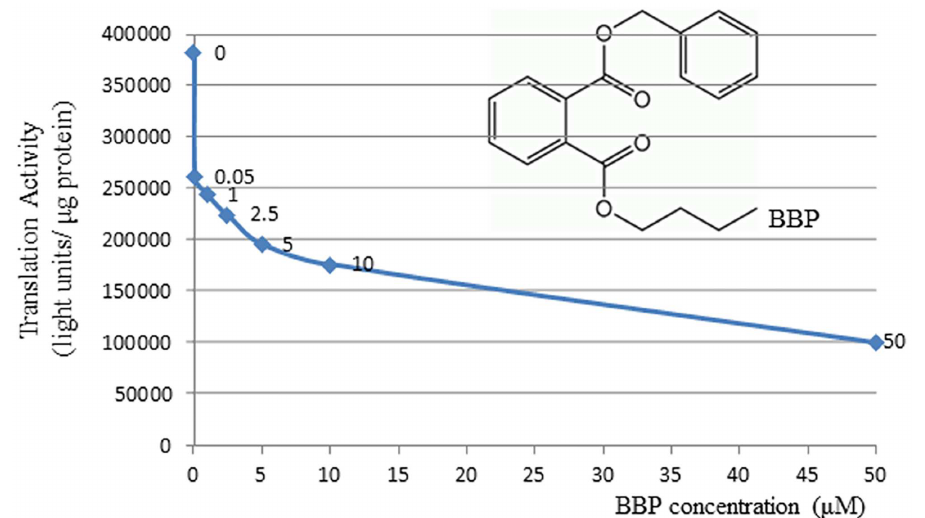
Fig 1. BBP inhibits mRNA translation in vitro . Rabbit reticulocyte lysate system was used to measurethe translation activity in vitro using luciferase mRNA as the reporter. BBP was added to the final concentrations as indicated.Equal volume of methanolonly was used as the control. Treatment with each concentration was repeatedthree times and the averagevalues were shown. The structure of BBP was insertedin the